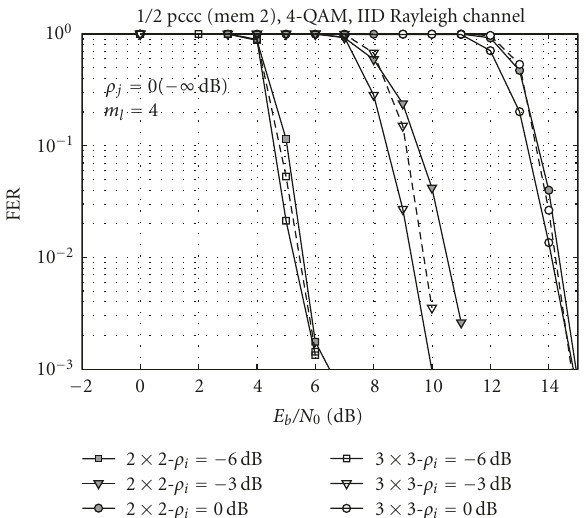
Figure 13: E ff ect of quantization of the exchanged decoder LLR values, where ρ i = 0dB. Curve labeled with “+” exchanges only those bits that have changed signs between iterations, and adaptively sets the number of quantization intervals during each iteration to reduce